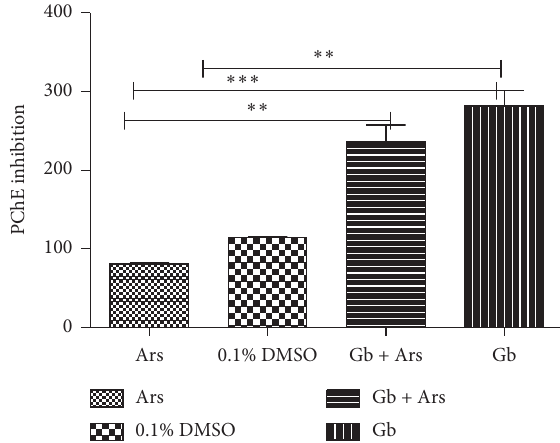
Figure 8: Propionylcholinesterase inhibition assay of adult Java- nese medaka ( Oryzias javanicus ) treated with arsenic, crude extract, and arsenic and crude extract. The percentage of propionylcholi- nesterase inhibition is shown versus concentration of the tested sample (arsenic, crude extract, and crude extract and arsenic). ∗ P < 0 . 001, P < 0 . 01, and P < 0 . 05 represents significant different values of the control group and group exposed to arsenic only, crude extract and arsenic, and crude extract only. The values represent mean ± SD from three ( n � 3) independent